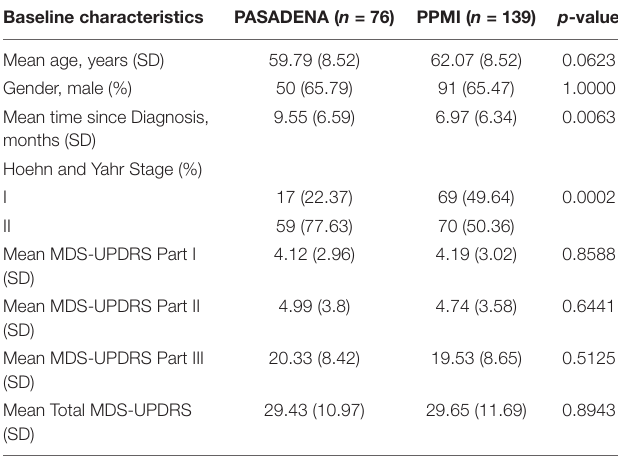
TABLE 1 | Demographic and baseline characteristics of PASADENA and PPMI